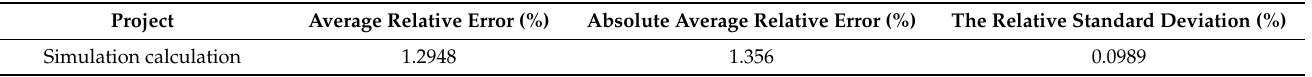
Table 8. Error analysis of the results of pressure recovery simulation calculation and test data.